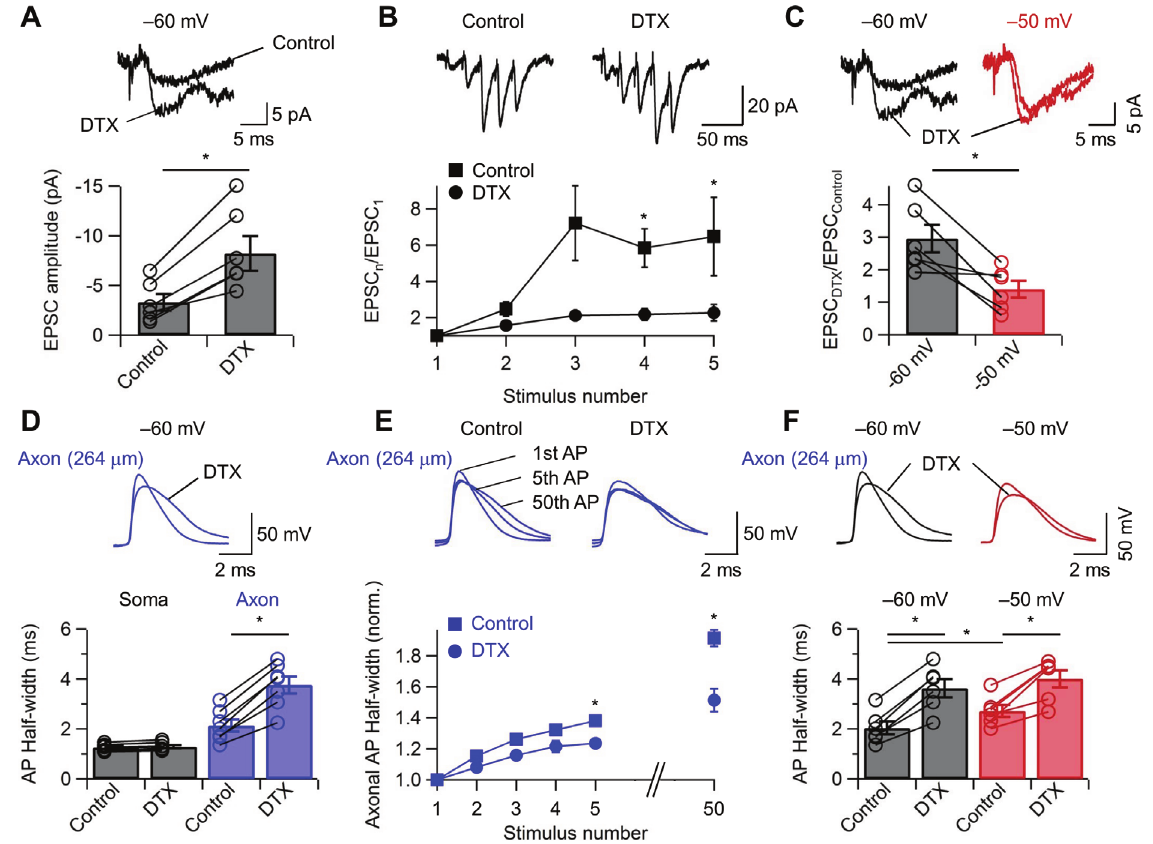
Figure 4. Modulation of synaptic transmission at CA1 pyramidal neuron–O-LM interneuron synapses is primarily controlled by axonal Kv1 channels. (A) Block of Kv1 channels enhances transmission. Top, unitary EPSCs at CA1 PN–O-LM IN synapses evoked by single presynaptic APs in control conditions and in the presence of 100 nM a -DTX. Traces represent averages from 10 single sweeps. Bottom, summary bar graph of the effects of a -DTX on EPSC peak amplitude. Note that a -DTX markedly increased synaptic efficacy. (B) Block of Kv1 channels reduces facilitation of transmission. Top, EPSCs at CA1 PN–O-LM IN synapses evoked by trains of five presynaptic APs in control conditions (left) and in the presence of 100 nM a -DTX (right). Bottom, facilitation ratio (EPSC n /EPSC 1 ), plotted against stimulus number, in control conditions (squares) and in the presence of a -DTX (circles). Somatic holding potential –60 mV. (C) Block of Kv1 channels abolishes static analog modulation of transmission. Top, unitary EPSCs at CA1 PN–O-LM IN synapses evoked by single presynaptic APs in control conditions and in the presence of 100 nM a -DTX. Presynaptic membrane potential were held at –60 mV (left; same recording as in (A)), and –50 mV (right). Bottom, summary bar graph of the effects of a -DTX on EPSC peak amplitude (EPSC DTX /EPSC Control ) for two different presynaptic holding potential (black, –60 mV; red, –50 mV). Note that a -DTX occluded the effects of changing membrane potential in the presynaptic neuron. (D) Block of Kv1 channels broadens the axonal AP. Top, axonal AP traces in control conditions and in the presence of 100 nM a -DTX. Bottom, summary bar graph showing the effects of a -DTX on half-duration of somatic and axonal AP. Axonal recording site is 264 m m from the soma. Note that a -DTX selectively increased axonal AP duration. (E) Block of Kv1 channels reduces activity-dependent AP broadening. Top, superposition of 1 st , 5th, and 50 th axonal AP in control conditions (left) and in the presence of 100 nM a -DTX (right). Bottom, plot of axonal AP half-width against stimulus number in control conditions (squares) and in the presence of 100 nM a - DTX (circles). Somatic holding potential –60 mV. Data from 7 recordings at distances of 200 to 500 m m. Axonal recording site is 264 m m from the soma. (F) Block of Kv1 channels reduces static AP broadening. Top, superposition of axonal APs in control conditions and in the presence of 100 nM a -DTX at –60 mV (left; same recording as in (D)), and –50 mV (right). Bottom, summary bar graph of the effects of a -DTX on AP broadening at –60 mV (black) and –50 mV (red). Note that the depolarization-induced AP broadening reduced the effect of a -DTX. Axonal recording site is 264 m m from the soma. Bars indicate mean 6 SEM. Open circles represent data from individual experiments. Data from the same experiment or for the same experimental conditions were connected by lines. *0.01 # P , 0.05.